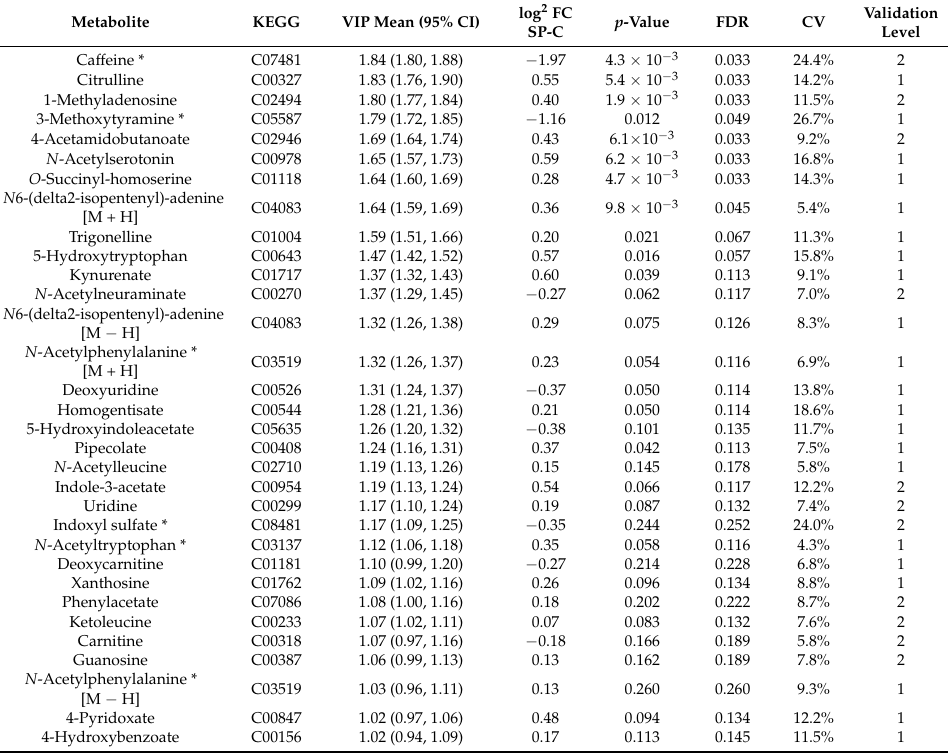
Table 4. Altered metabolites with an average VIP score greater than or equal to 1.0 from the PLS-DA comparing SPMS patients with controls. A positive log 2 fold change (FC) SP-C indicates an averaged increase in SPMS patients compared with controls and vice versa. Identities confirmed by m / z and elution time of the internal standards and by MS/MS fragmentation pattern (validation level 2). Identities confirmed by m / z and elution time of the internal standards (validation level 1). Coefficient of variation (CV) is reported for all altered metabolites in the QC